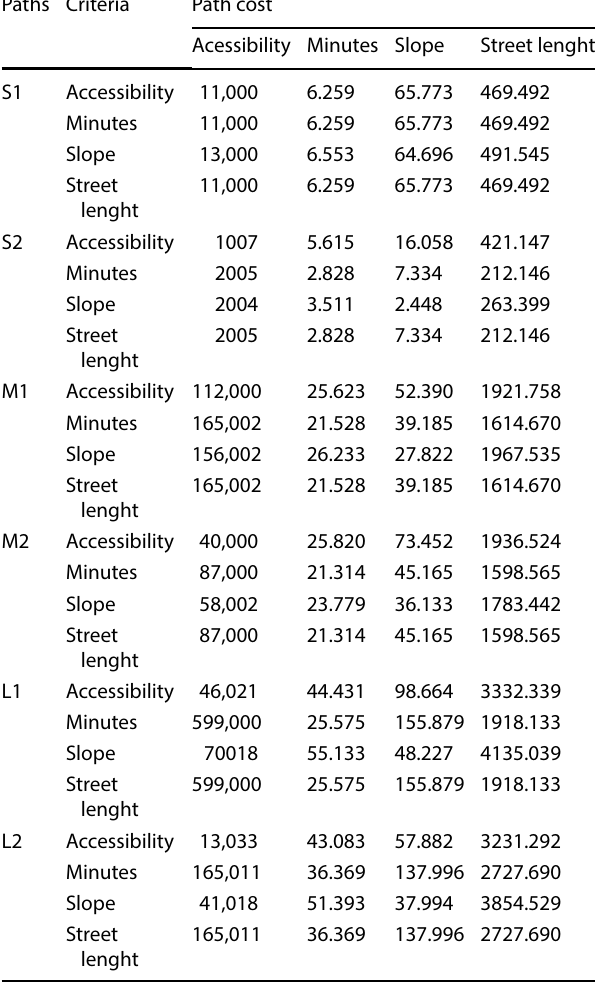
Table 5 Obtained results in terms of the four measures Paths